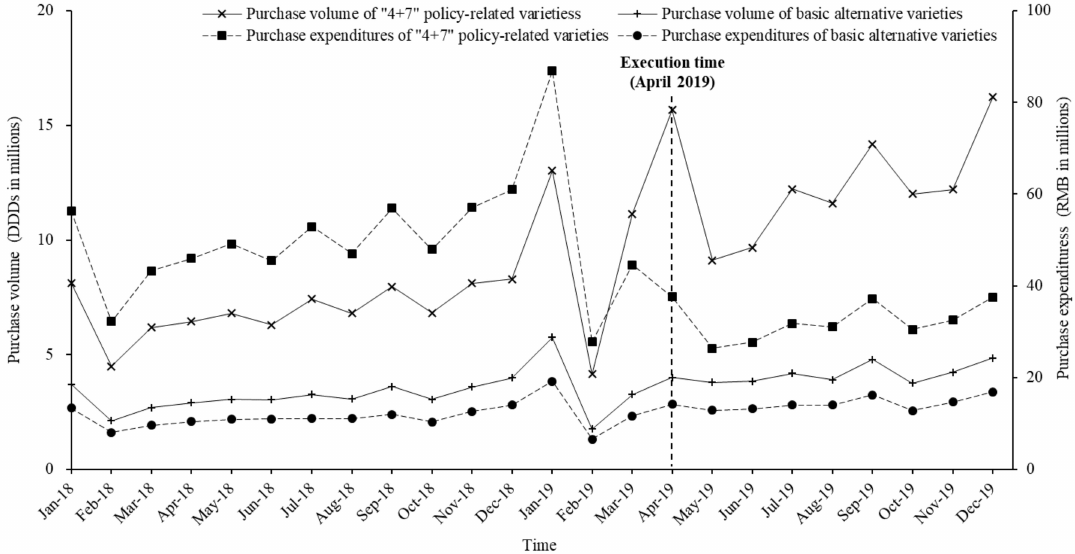
Figure 2. Monthly trends of volume and expenditures of “4 + 7” policy-related varieties and basic alternative varieties from January 2018 to December